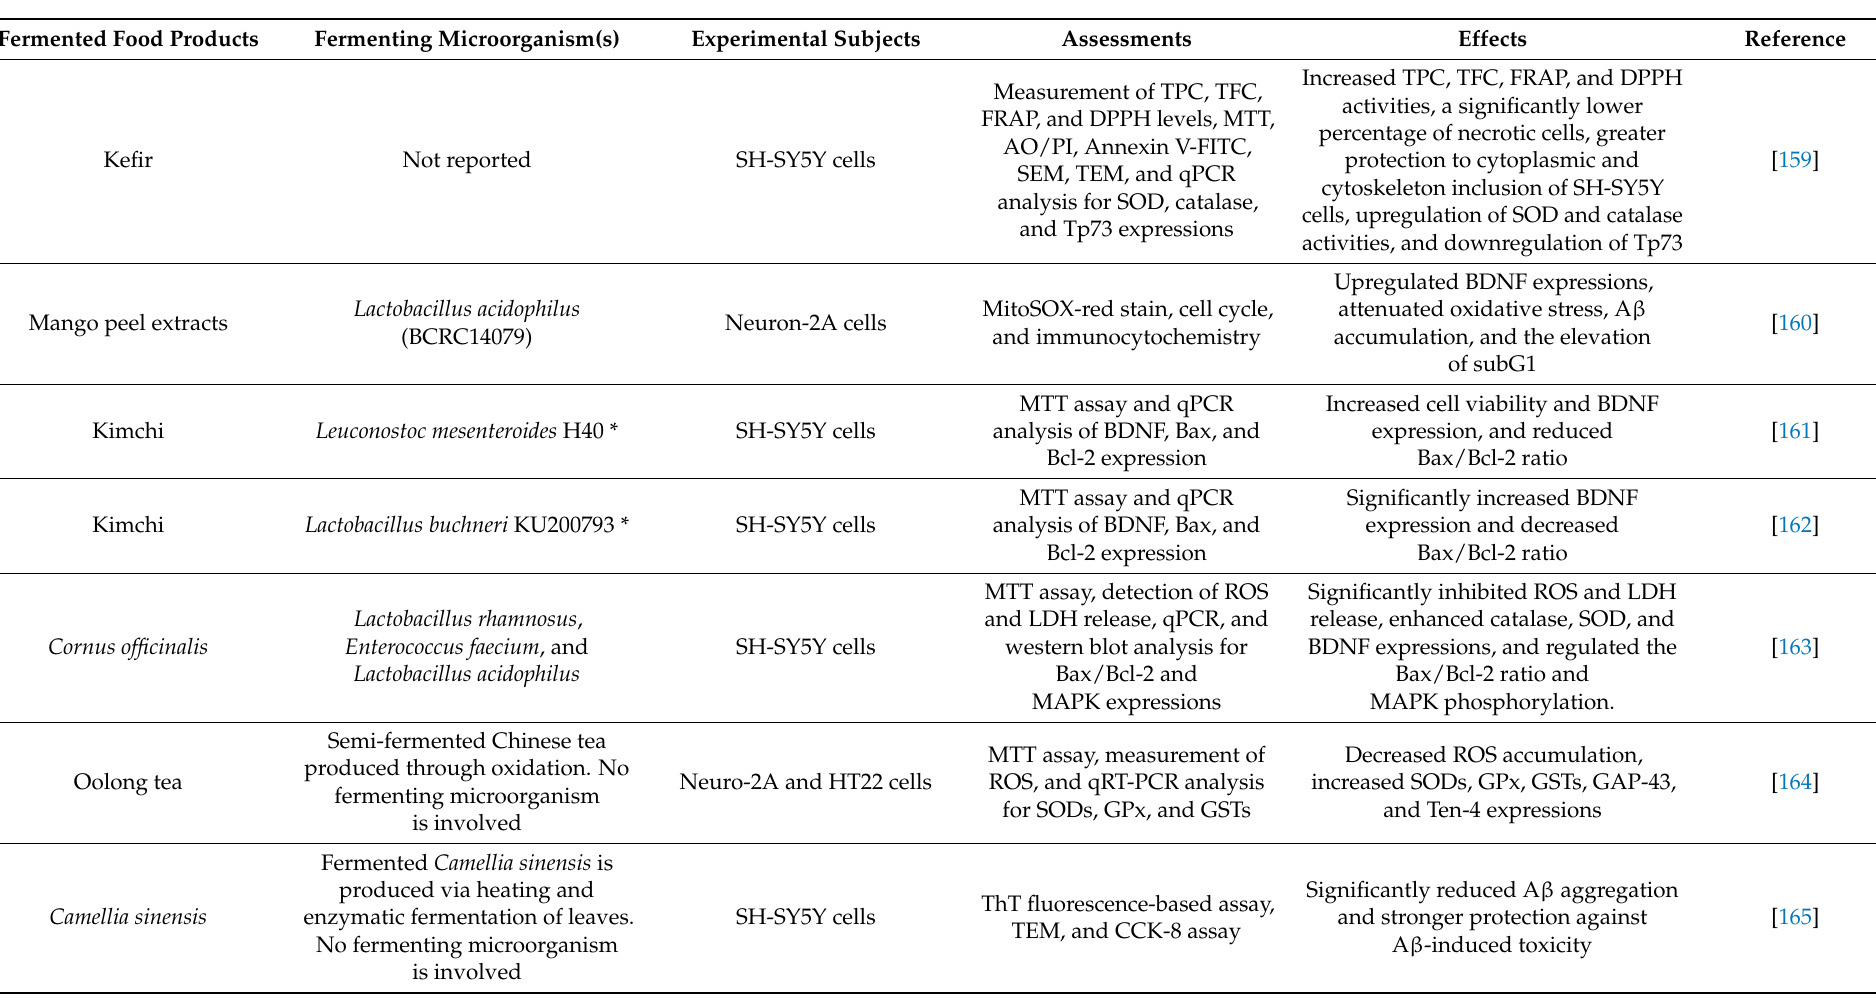
Table 4. Preclinical in vitro studies of fermented foods and their effects on